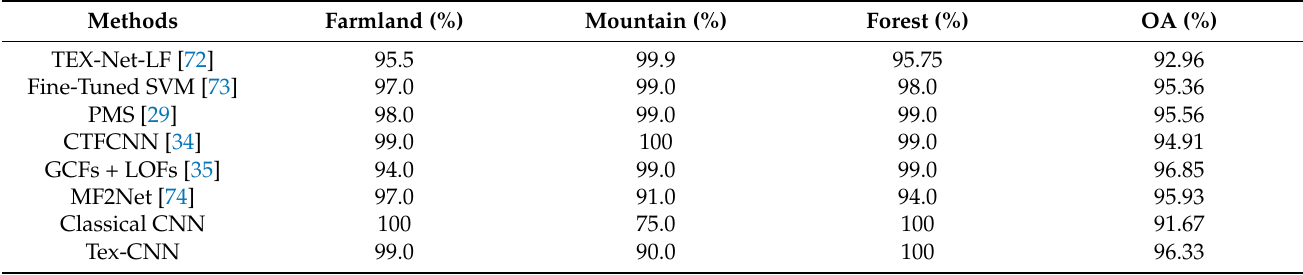
Table 3. Overall accuracy (OA) and selected per-scene class accuracy for reference and our proposed Tex-CNN on the AID.